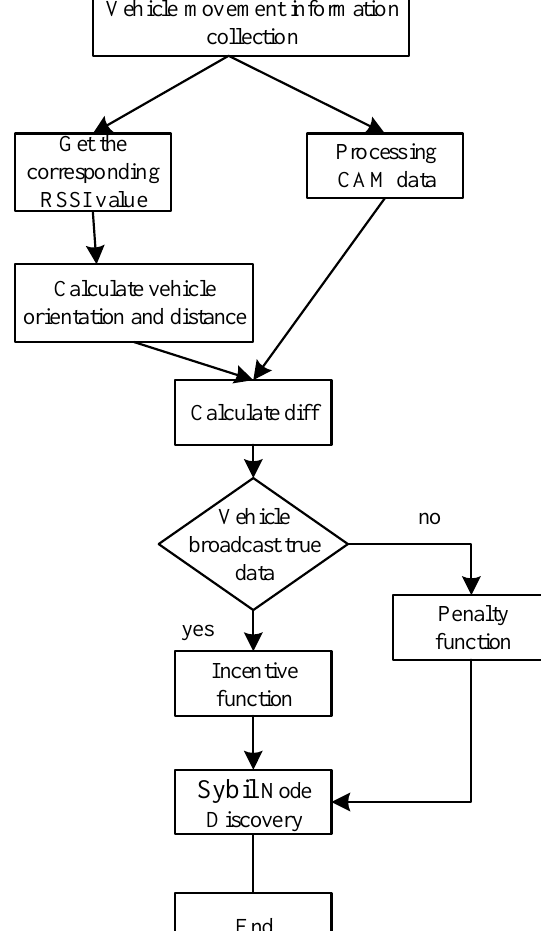
Figure 3. Flow chart of Sybil node discovery based on the punishment incentive.